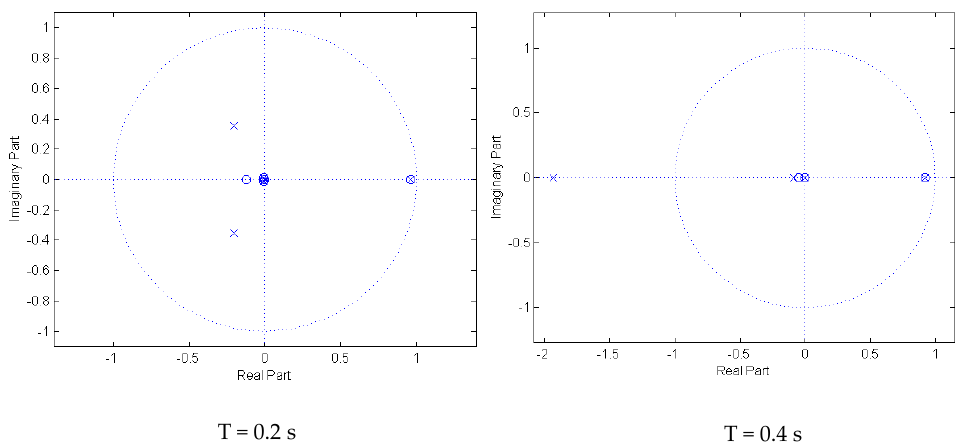
T = 0.2 s T = 0.4 s Figure 5. Poles location with different task scheduling period T . Figure 5. Poles location with different task scheduling period T Figure 5. Poles location with different task scheduling period T .